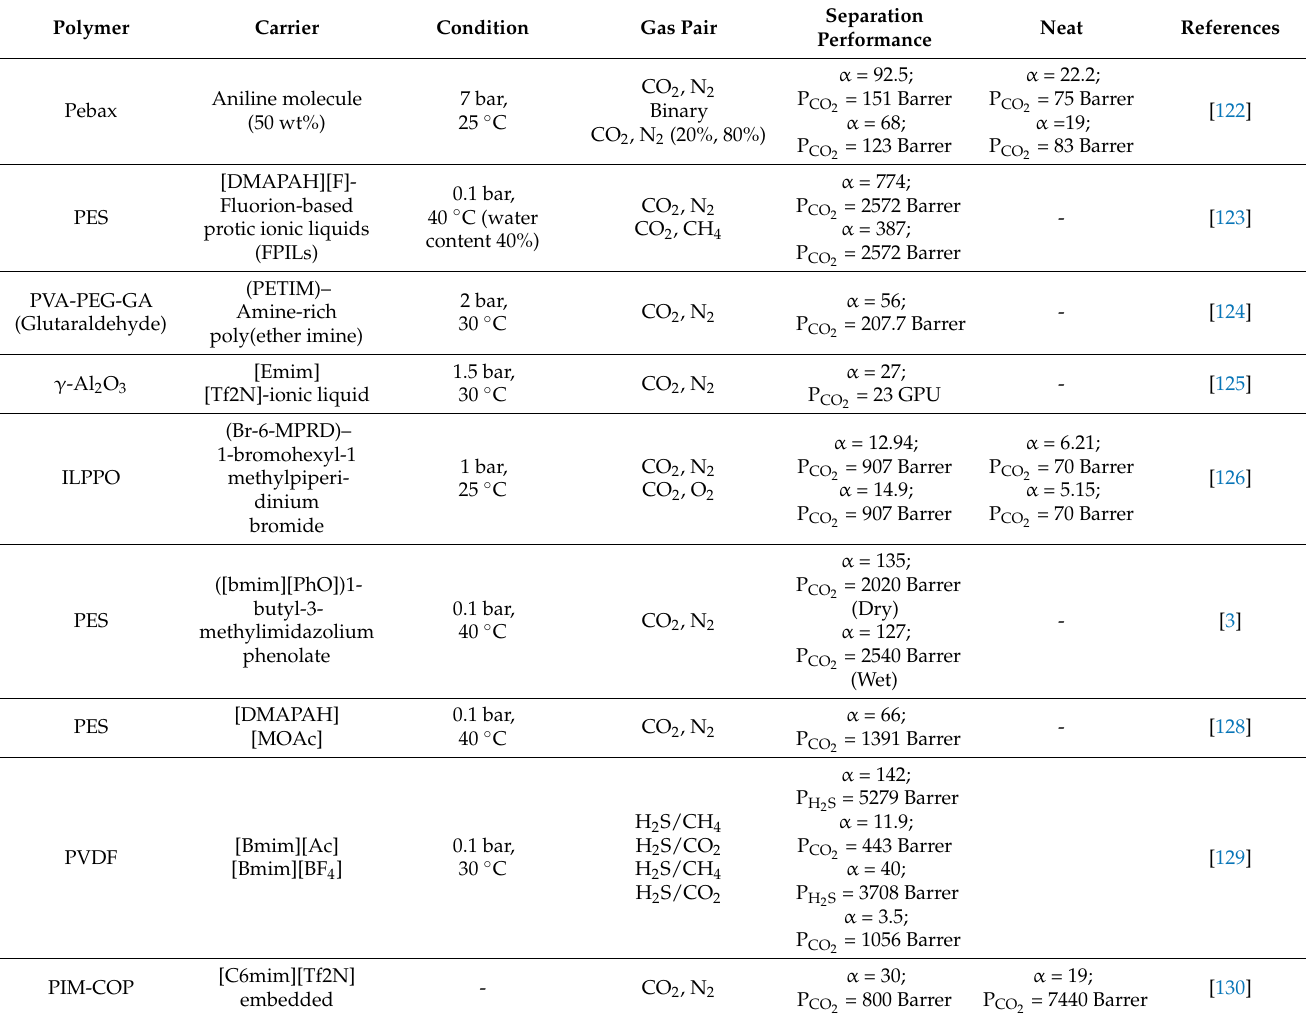
Table 5. Performance comparison of some recently reported